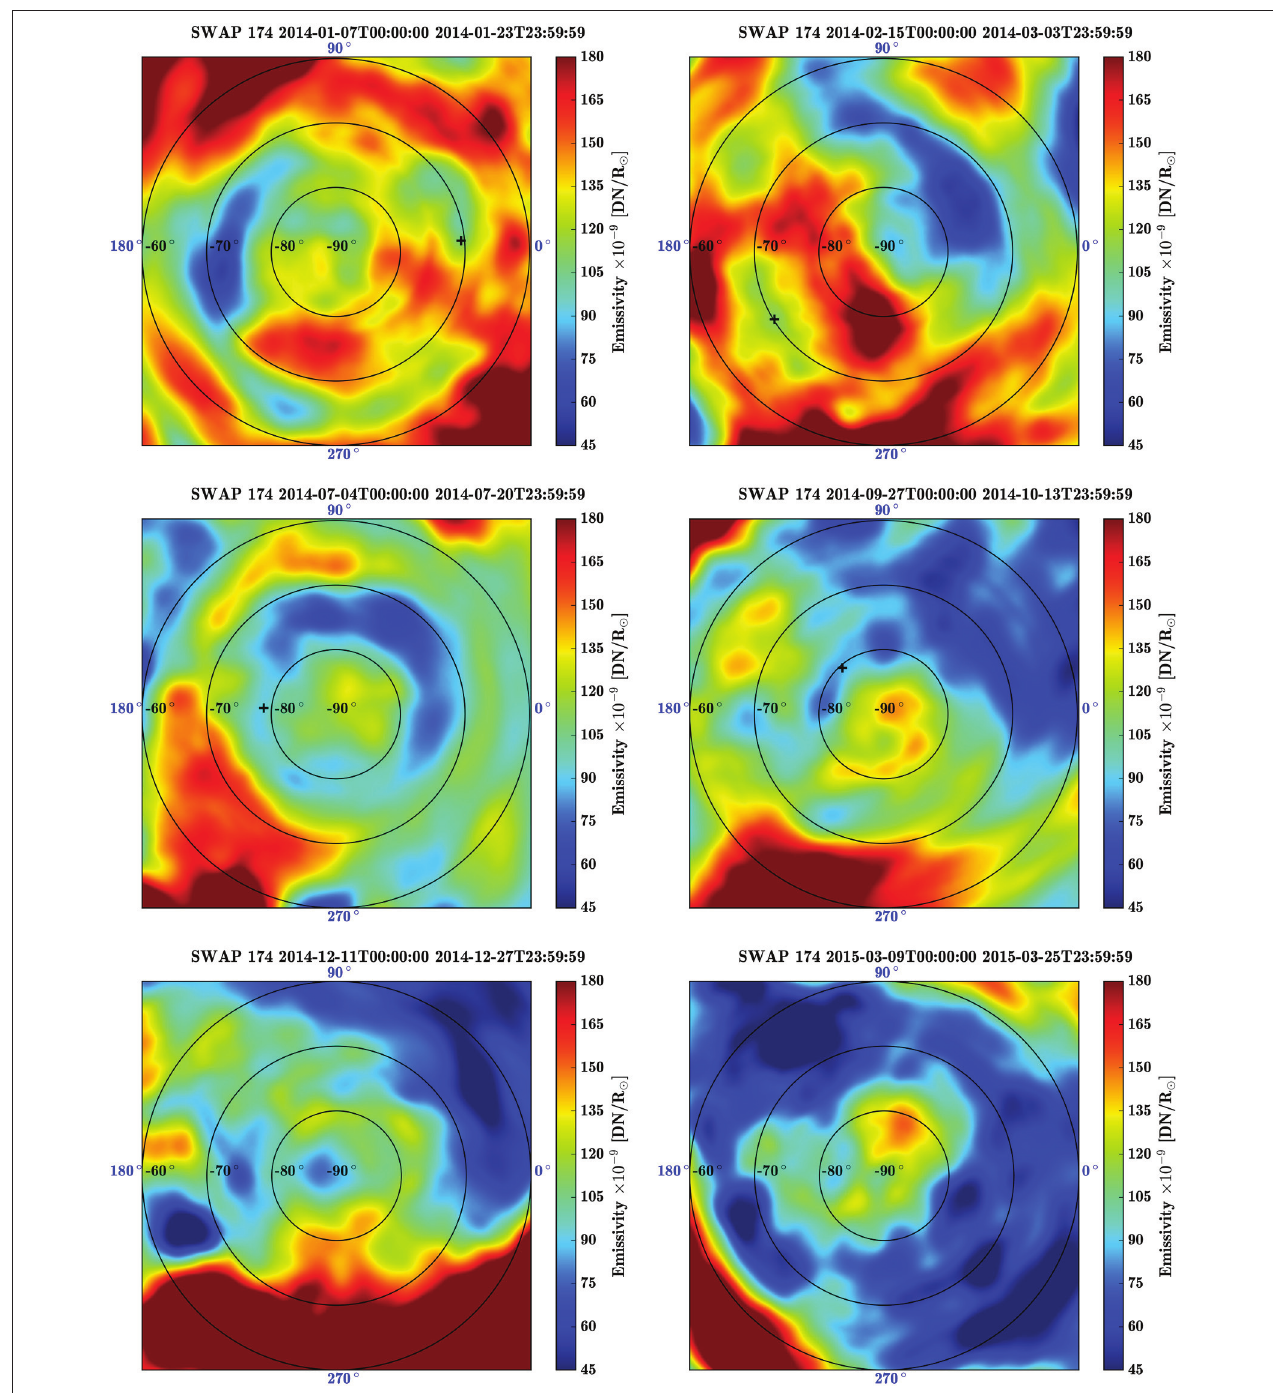
FIGURE 3 | SWAP polar view of the south pole at 1.05 R ⊙ for select tomographic reconstructions corresponding to the images in Figure 1. The black plus represents the position of the cavity center (see text for details).